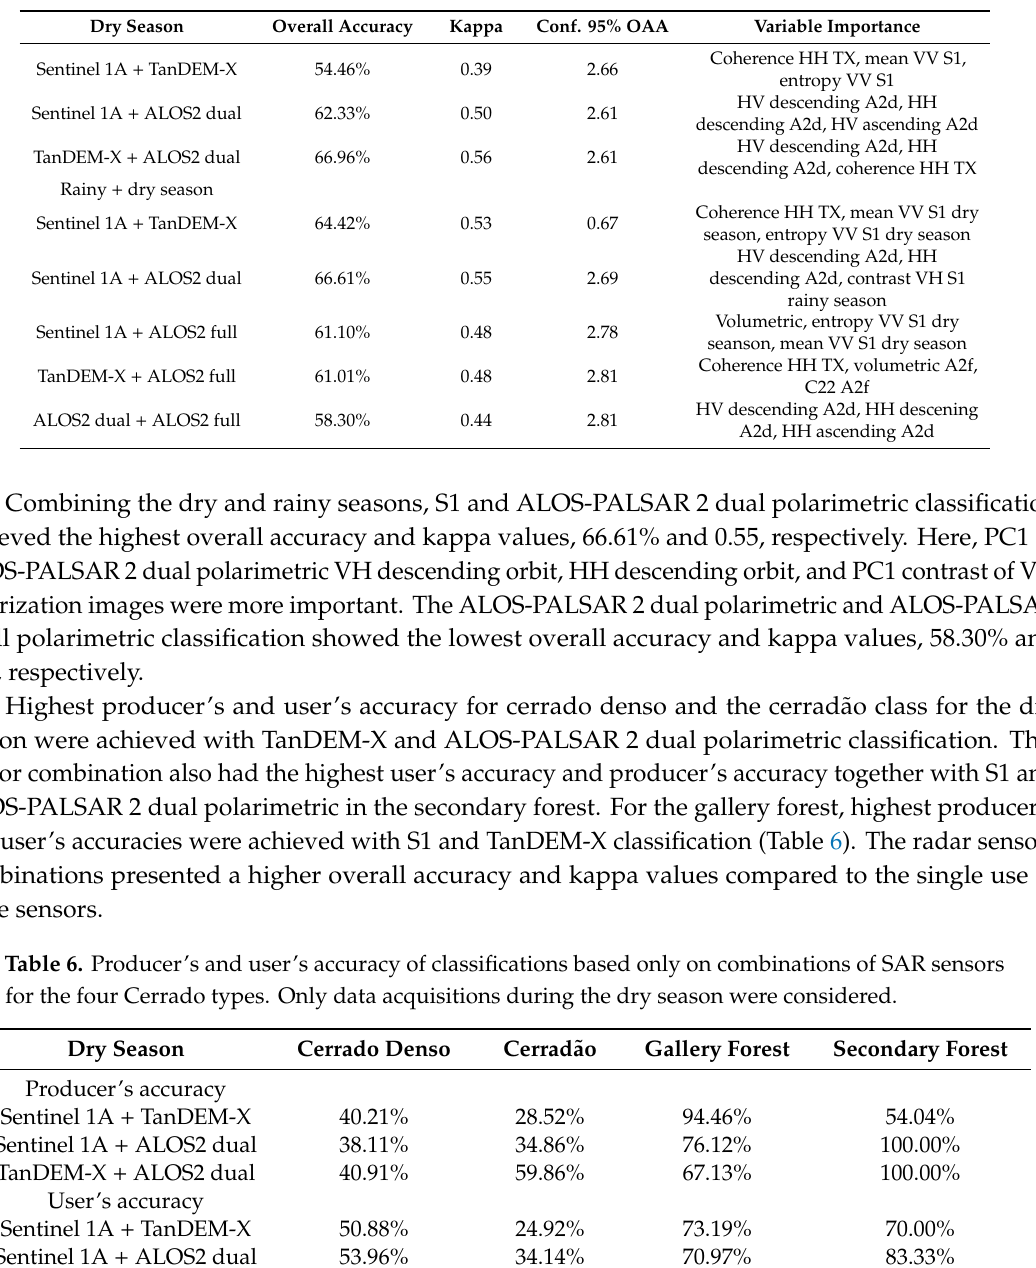
Table 5. Overall accuracy, kappa values, confidence interval 95% OAA, and the three most important variables for the classifications based on the Random Forest variable importance for Sentinel 2A (S2), ALOS PALSAR 2 full (A2f), ALOS PALSAR 2 dual (A2d), TanDEM X (TX), and Sentinel 1A (S1). The parameters listed in the variable importance are the PC1 derived from the PCA except for the images from TanDEM-X, as only one acquisition was available.